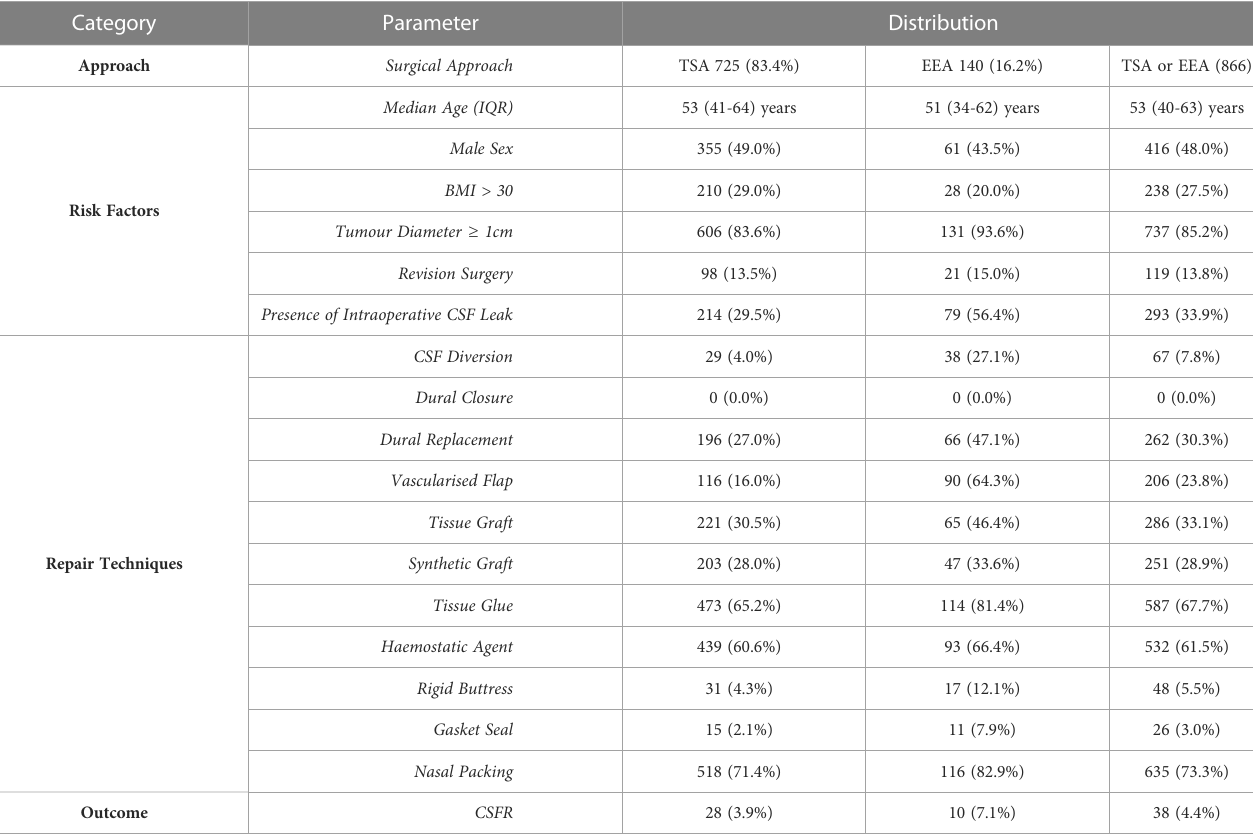
TABLE 1 Distribution details of variables (predictors, approach, outcome) split by approach